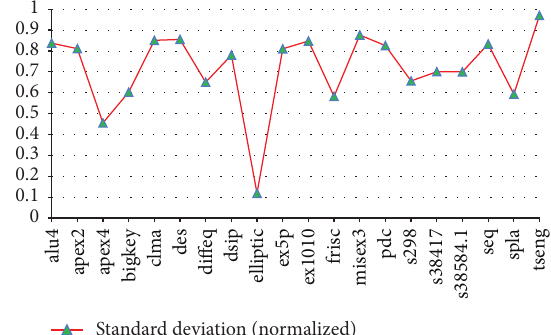
Figure 8: Comparative results of standard deviation in interconnect demand for diffusion based placement algorithm using 1-sigma approach normalized to the respective results from VPRs placement algorithm for cluster size 𝑁 = 4 .